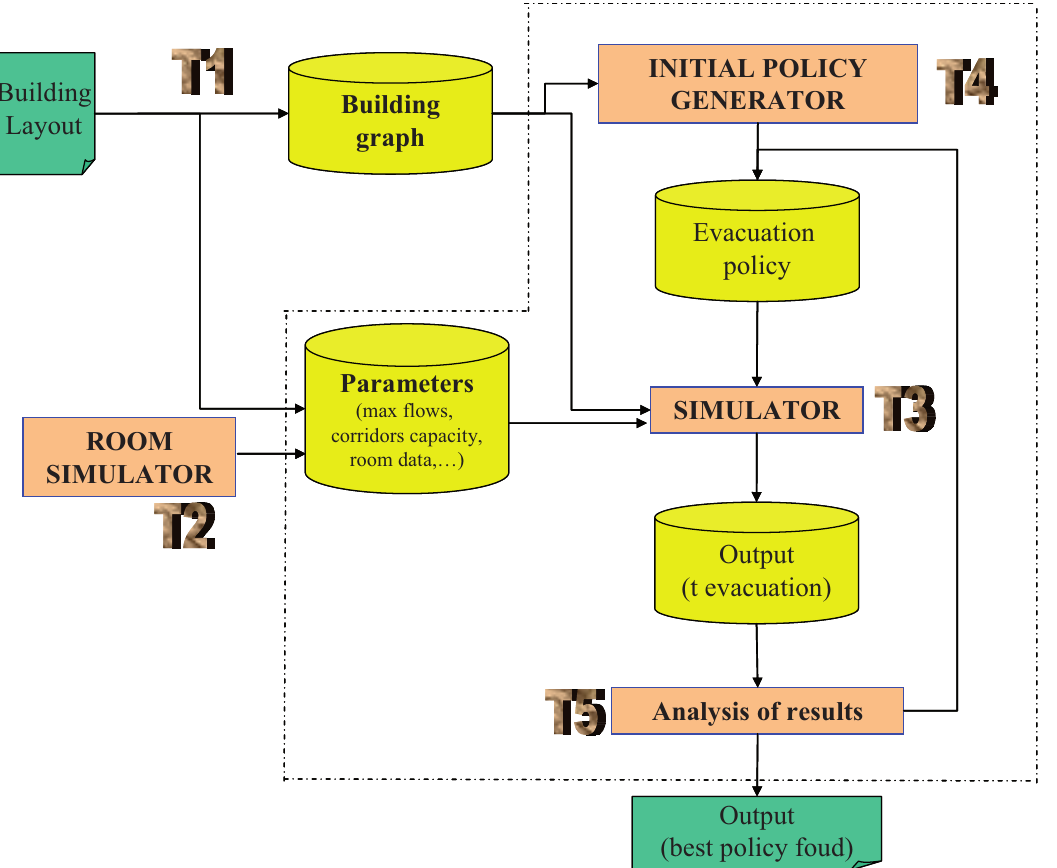
Fig. 1. Interrelationships among the modules of the designed